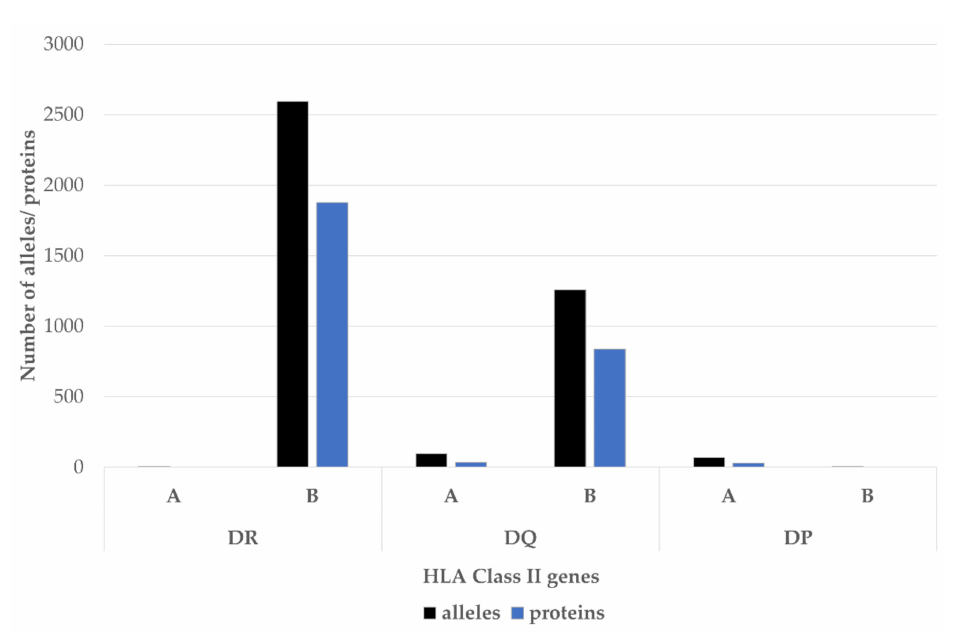
Figure 3. The HLA class II beta chains are much more polymorphic than the alpha chains. The most polymorphic HLA class II locus is HLA-DRB1-2690 alleles of this gene have been identified. Source: adapted from http: // hla.alleles.org / nomenclature / stats.html; accessed on 21 April